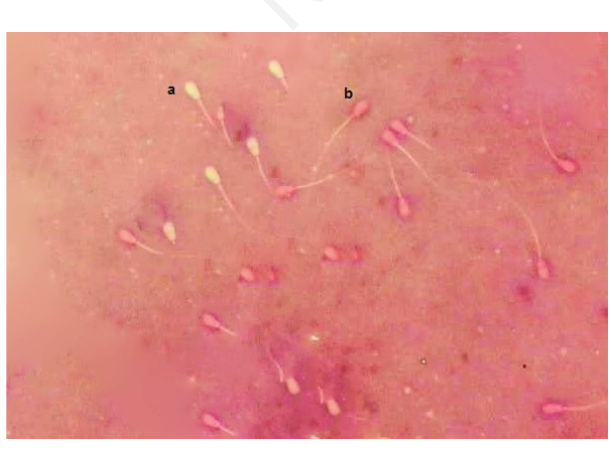
Figure 1. Sperm viability observed under Phase Contrast Microscope (200x). a) Live Sperm; b) Dead Sperm.